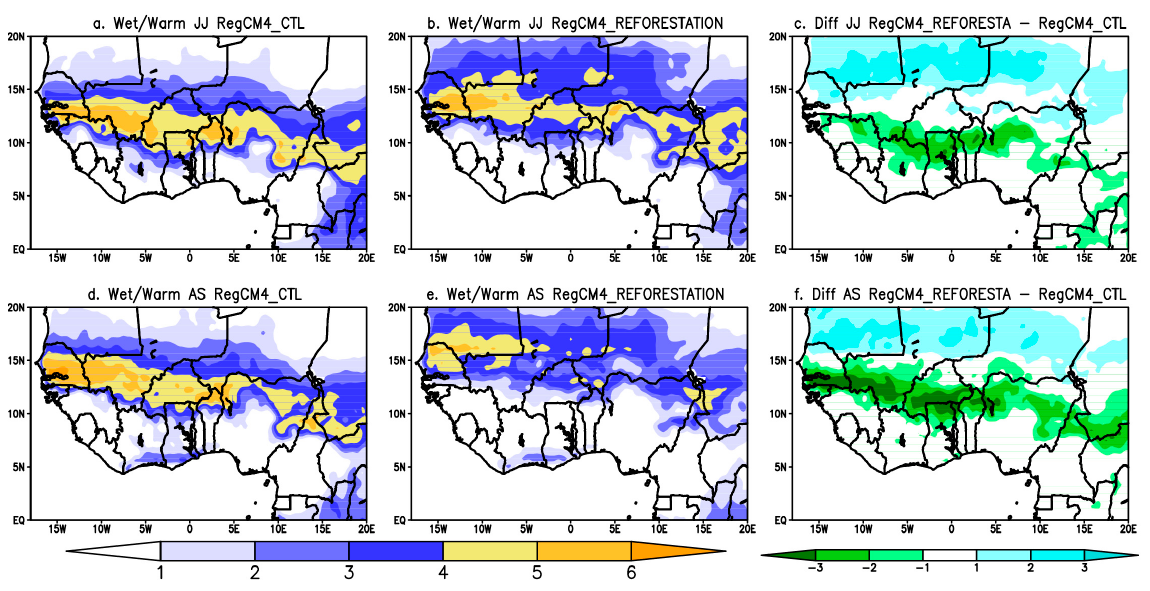
Figure 10. Number (expressed in days) of extreme wet/warm days during the June–July (JJ) and August–September (AS) periods averaged from 1990 to 2009 over West Africa for: ( a , d ) RegCM4_CTL; ( b , e ) RegCM4_REFORESTATION and ( c , f ) RegCM4_REFORESTATION— RegCM4_CTL.